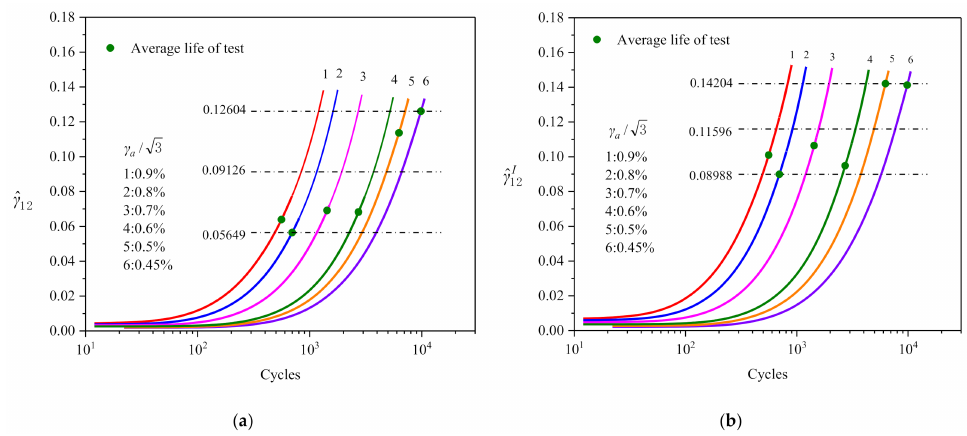
Figure 13. ( a , b ) Evolution of parameter ˆ γ and ˆ γ I with cycle numbers, respectively. 12 12 In Figure 13a,b, the corresponding critical point can be determined on the parameter curve of a certain specified strain amplitude according to the test fatigue life, then draw a horizontal line across the critical point (the dotted line in the graph). The abscissa, N fi , of the intersection point between the horizontal line and the curve corresponding to the i - th strain amplitude E ai is the predicted fatigue life of the corresponding shear strain amplitude and then the predicted life curve can be obtained ( E ai ∼ N fi ). According to this method, the fatigue failure is predicted by using the curves in Figure 13 and the critical value range of fatigue parameters ˆ γ is 0.05649–0.12604, and - ˆ γ I is 0.08988–0.14204. 12 12 According to the maximum value (0.12604), median value (0.09126) and minimum value (0.05649) of ˆ γ and the corresponding horizontal lines in Figure 13a, three of point 12 sequences ( γ a ∼ N f ) between strain amplitude and predicting fatigue life are obtained, and they are drawn in Figure 14a. Similarly, another three of point sequences can also be obtained according to the maximum value (0.14204), median value (0.11596) and minimum value (0.08988) of ˆ γ I (cf. Figure 13b), and are drawn in Figure 14b. Thus, by using the 12 above method the upper bound, median and lower bound predictions of fatigue life can be obtained.